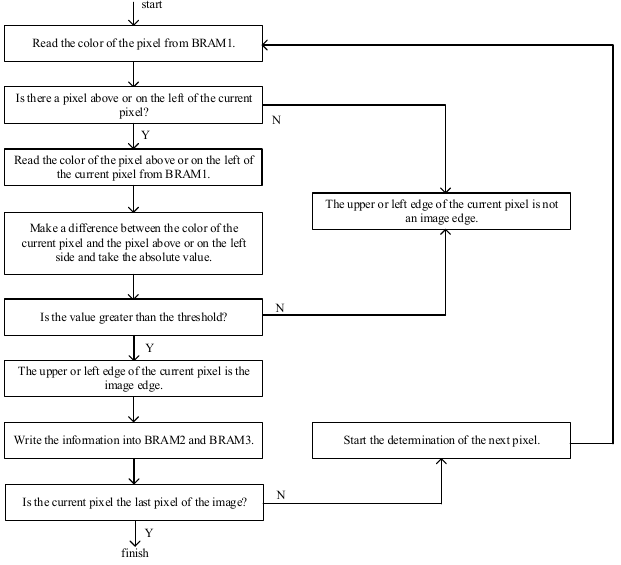
Figure 9. Flow diagram of the module Generate_Edge. After reading the color of the pixel above or on the left side of the current pixel, we note the difference between the color of the current pixel and the pixel above or on the left side and take the absolute value. If the absolute value is greater than our preset threshold, we can determine that the upper edge or the left edge of the pixel is the image edge; otherwise, we can determine that the upper or left edge of the current pixel is not an image edge. After determining whether the edge of the current pixel is the image edge, we first store the information in BRAM2 and BRAM3, and then we determine whether the current pixel is the last pixel of the image. If the current pixel is the last pixel of the image, it means that we have completed the edge detection of the image; otherwise, we need to continue to determine whether the edge of the next pixel is the image